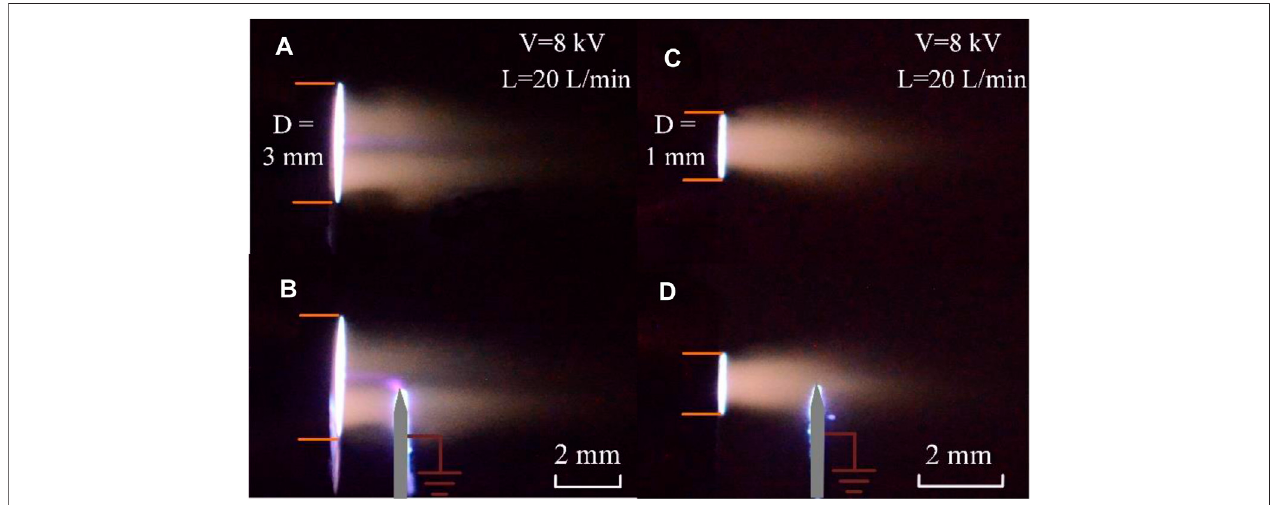
FIGURE2| Opticalphotosoftheairplasmajetwithdifferentdiametersnozzles.Thenozzlediameteris3 mmin (A,B) and1 mmin (C,D) .Thedistancebetweenthe pin tip and the nozzle center is 2 mm in (B,D) . The air fl ow rate of air is 20 L/min. The amplitude of the voltage is 8 kV.